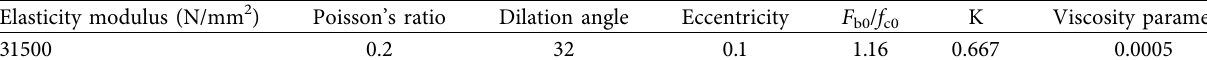
Figure 4: Stress-strain curves of concrete in walls and floors except unbonded region (a) In pressure (b) In tension. Table 1: The parameter value of concrete material in walls and floors except unbonded region.